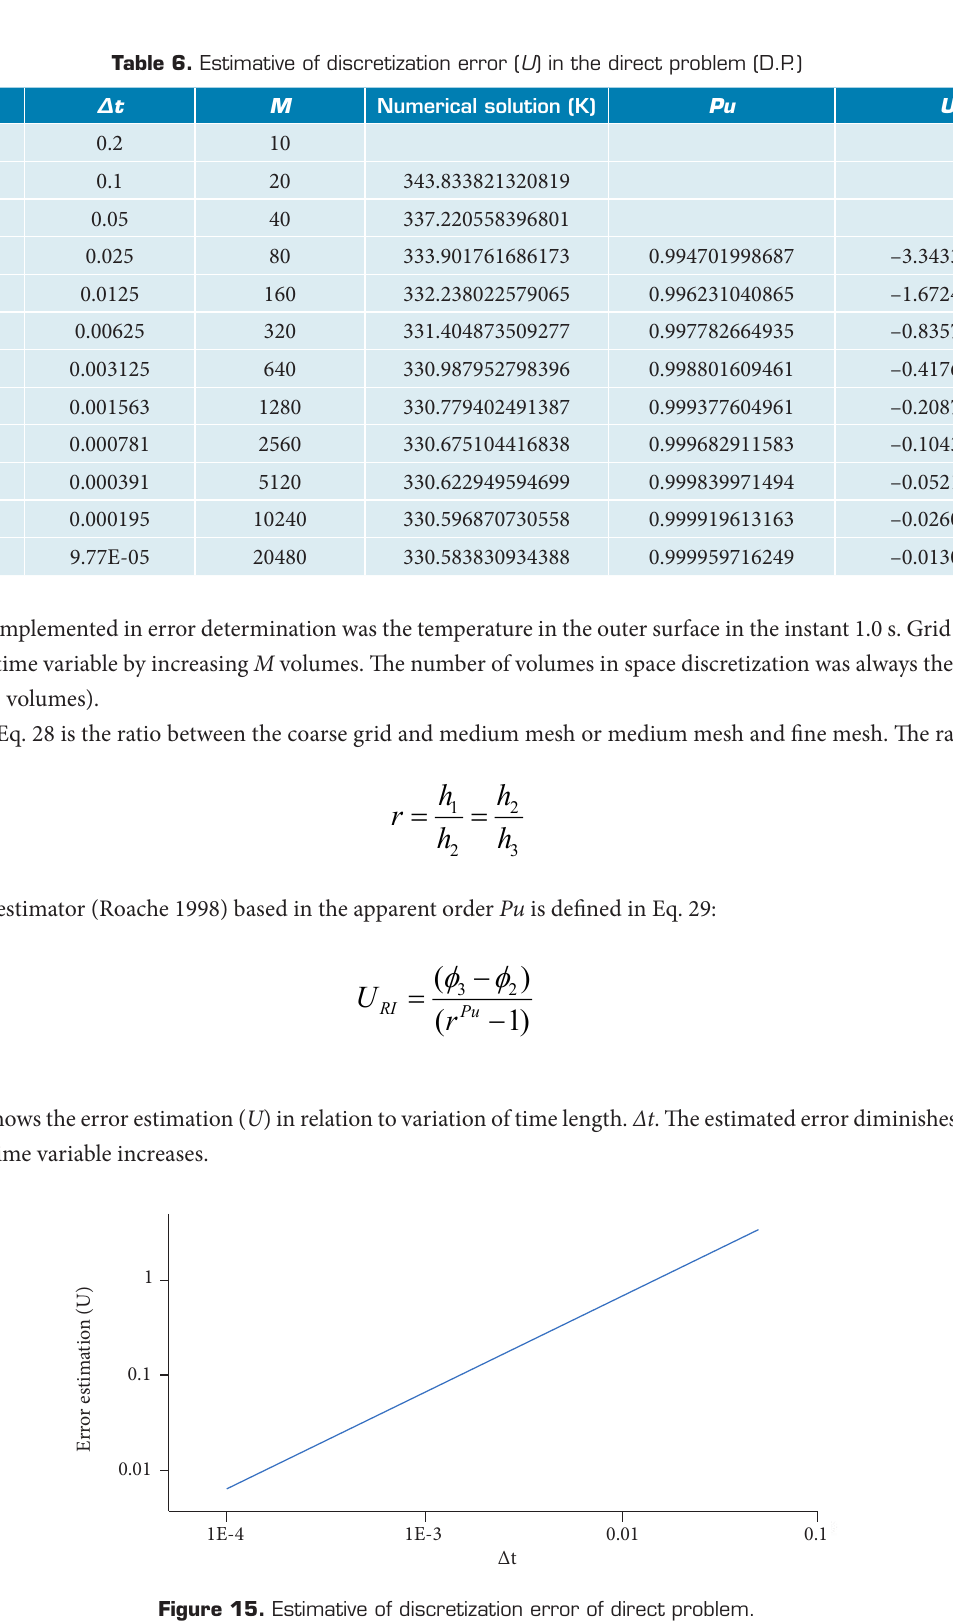
Figure 15. Estimative of discretization error of direct